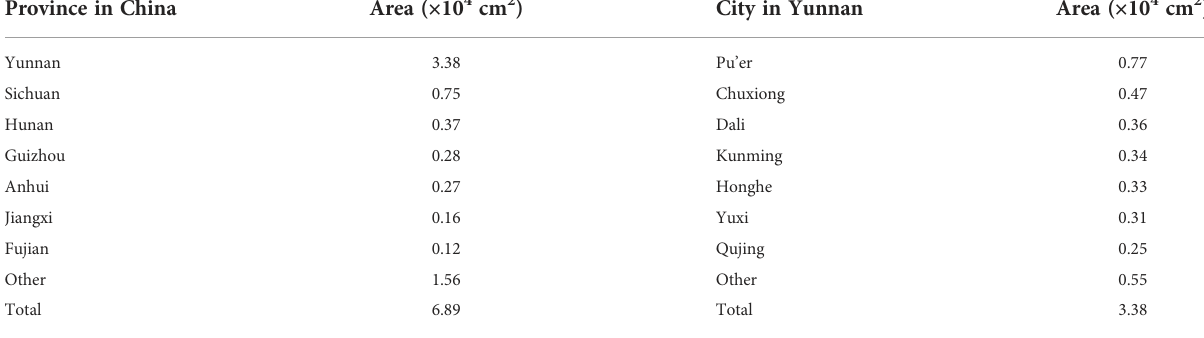
TABLE 2 The distribution area of suitable habitat for W. cocos .